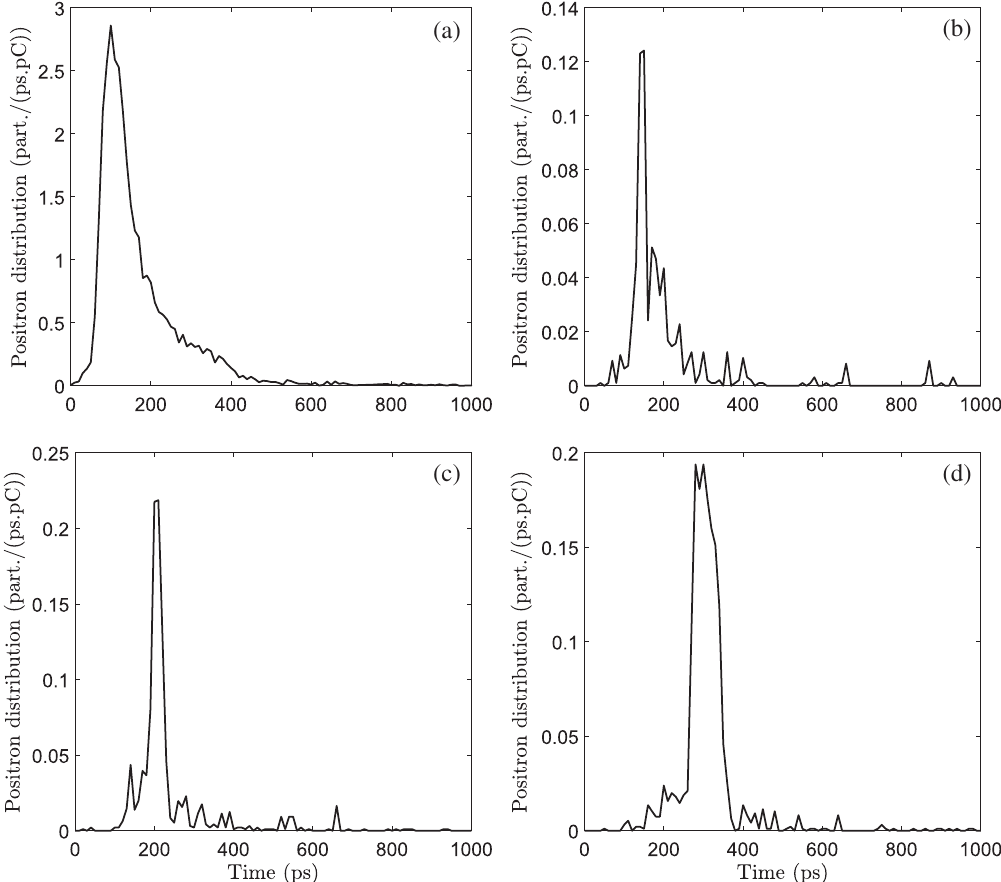
FIG. 11. Temporal distribution of the positrons after the dogleg: for the whole spectrum (a), for positrons with an energy of 1 (cid:2) 0 . 05 MeV (b), for positrons with an energy of 700 (cid:2) 50 keV (c), for positrons with an energy of 500 (cid:2) 50 keV